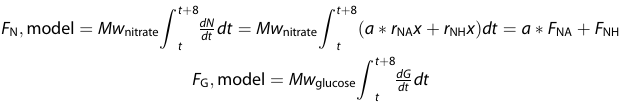
T pump ; N : Nitrate pump running time every 8 h ð s Þ T pump ; G : Glucose pump running time every 8 h ð s Þ Closed-loop system . Initial biomass levels ( x 0 ), glucose levels ( G 0 ) and nitrate levels ( N 0 ) were measured and used as inputs into the closed-loop system.